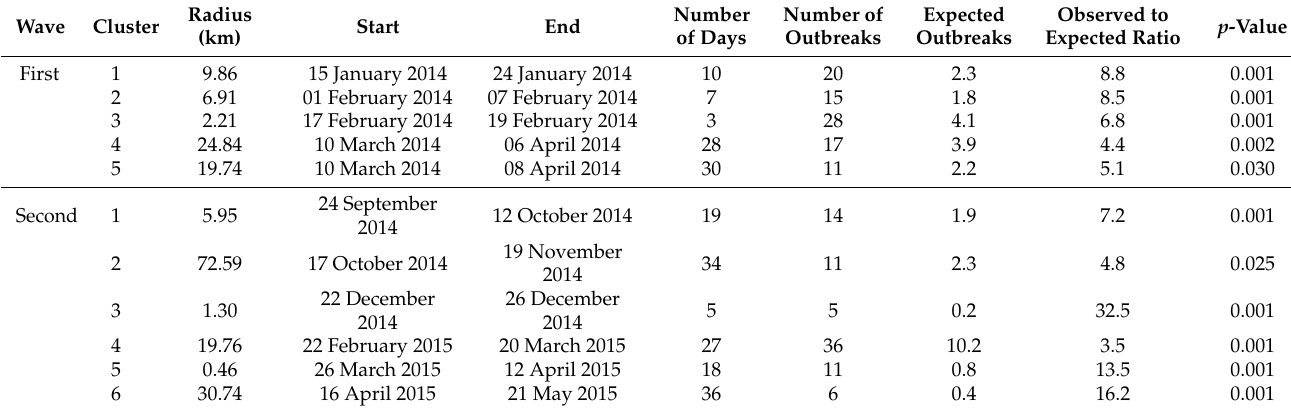
Table 2. Spatiotemporal cluster of Korea poultry farms during HPAI H5N8 outbreaks from 2014 to 2016. Wave